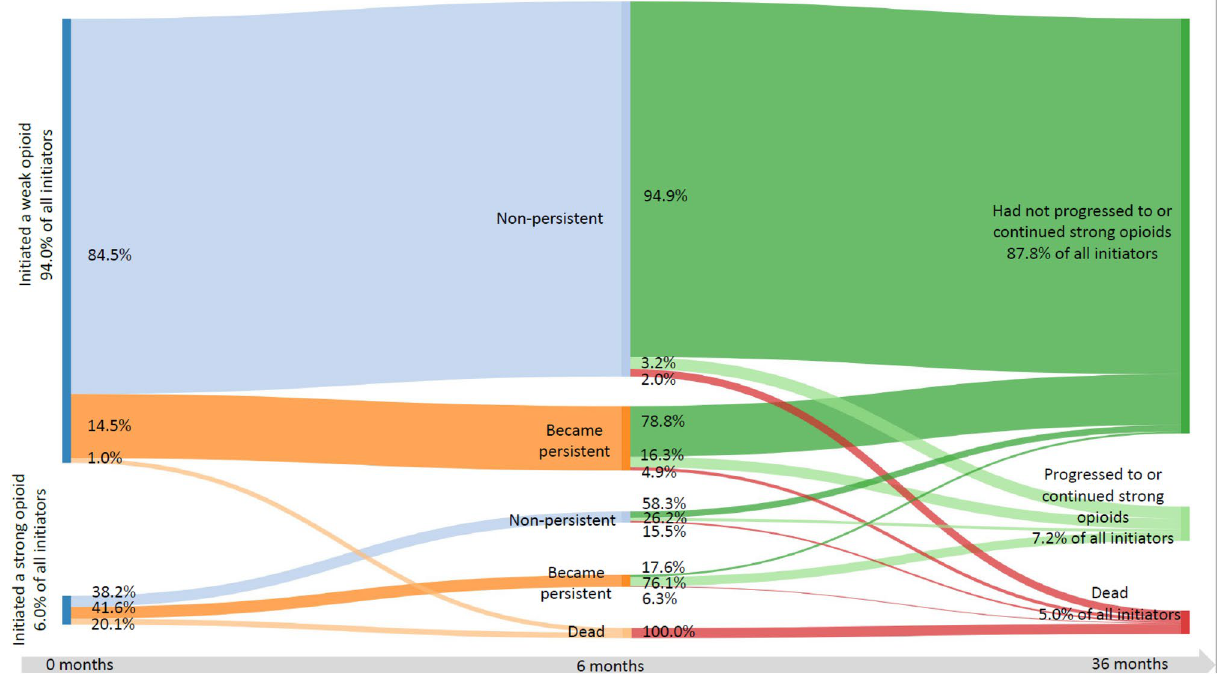
Figure 4. Patterns of opioid use in three-year follow-up for patients who initiated opioid therapy in 2009-2014 (n = 1,370,057). Persistent use was defined as more opioids dispensed between months 3-6 after the initial dispensed